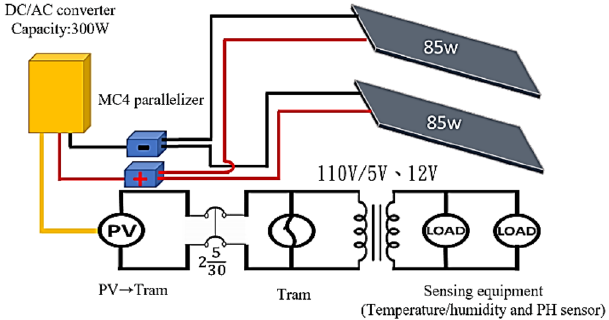
Figure 7. Schematic of the adopted grid-connected solar power